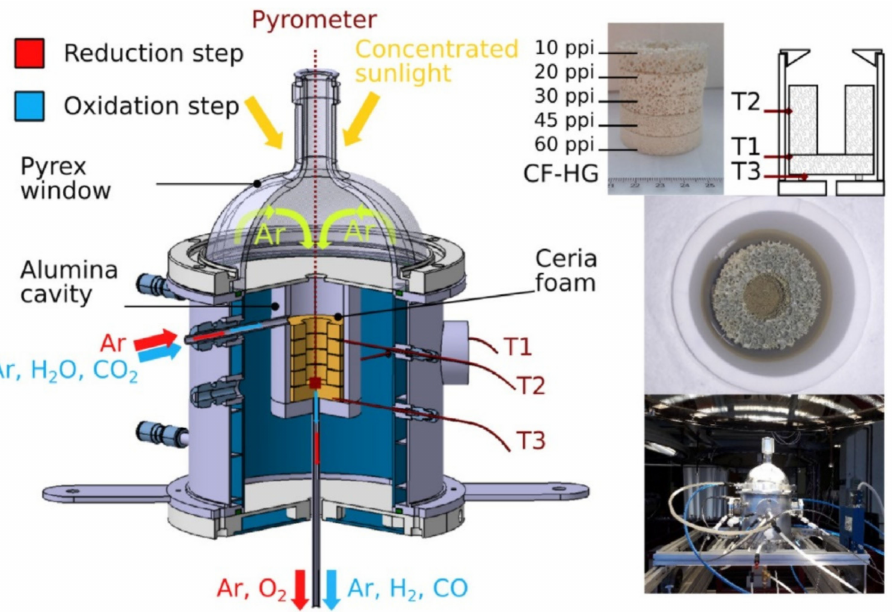
Figure 13. Schematic of the 1.5-kW th directly irradiated solar reactor equipped with a series of ceria RPCs with 10–60-ppi gradient pore sizes used for H 2 O or CO 2 splitting